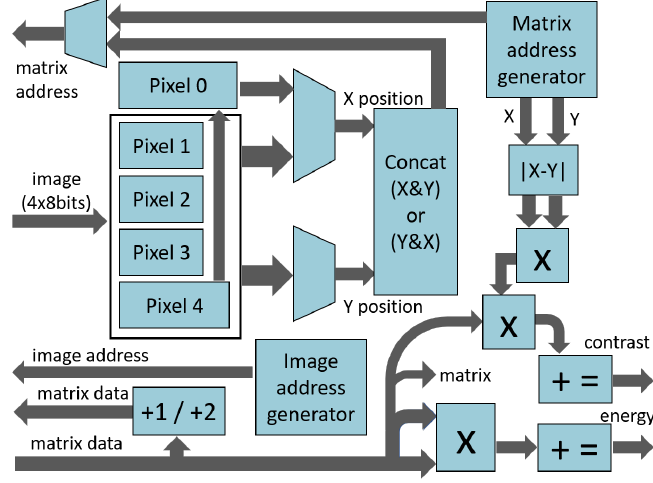
Figure 16. Algorithm block